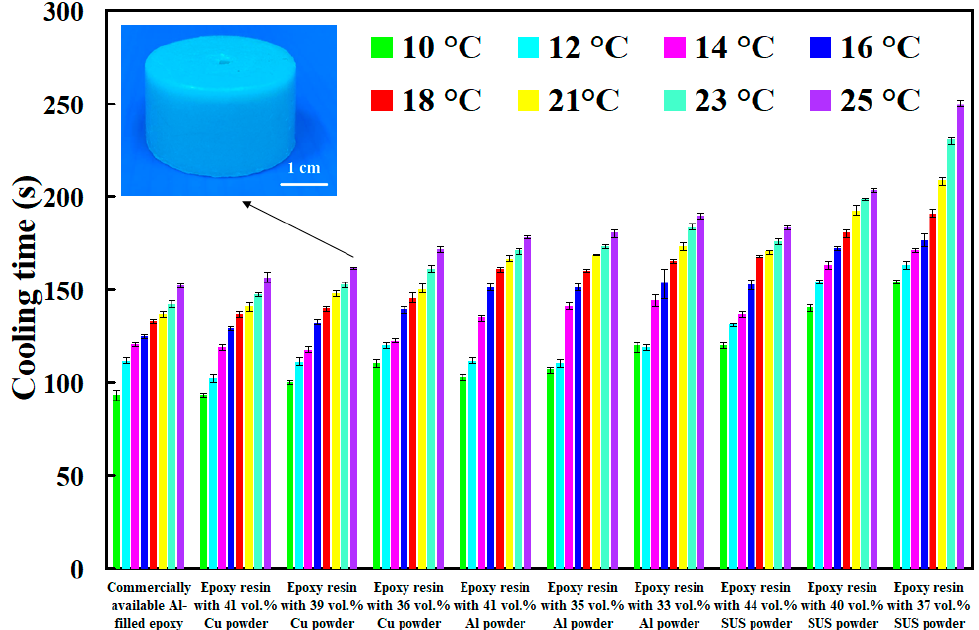
Figure 18. Cooling time of injection molded parts fabricated by ten sets of injection molds cooled with different cold air temperatures.